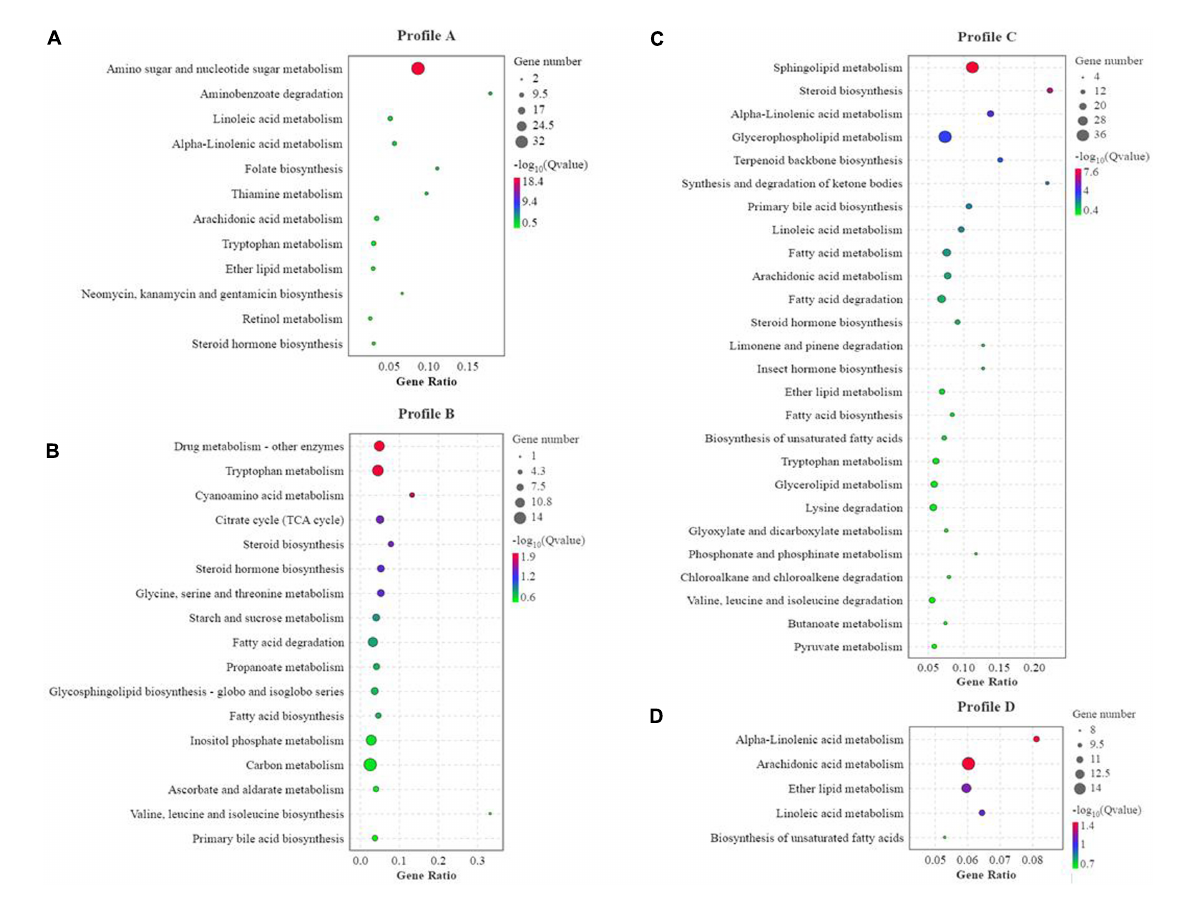
FIGURE4 KEGG enrichment analysis of differential genes of different soy meals substitute for fish meal in hindgut of pearl gentian grouper ( n = 4). (A) KEGG enrichment of co-contained DEGs in SBM40, SPC40, and FSBM40 group related to nutrition metabolism; (B) KEGG enrichment of unique DEGs in SBM40 group related to nutrition metabolism; (C) KEGG enrichment of unique DEGs in SPC40 group related to nutrition metabolism; (D) KEGG enrichment of unique DEGs in FSBM40 group related to nutrition metabolism ( n =